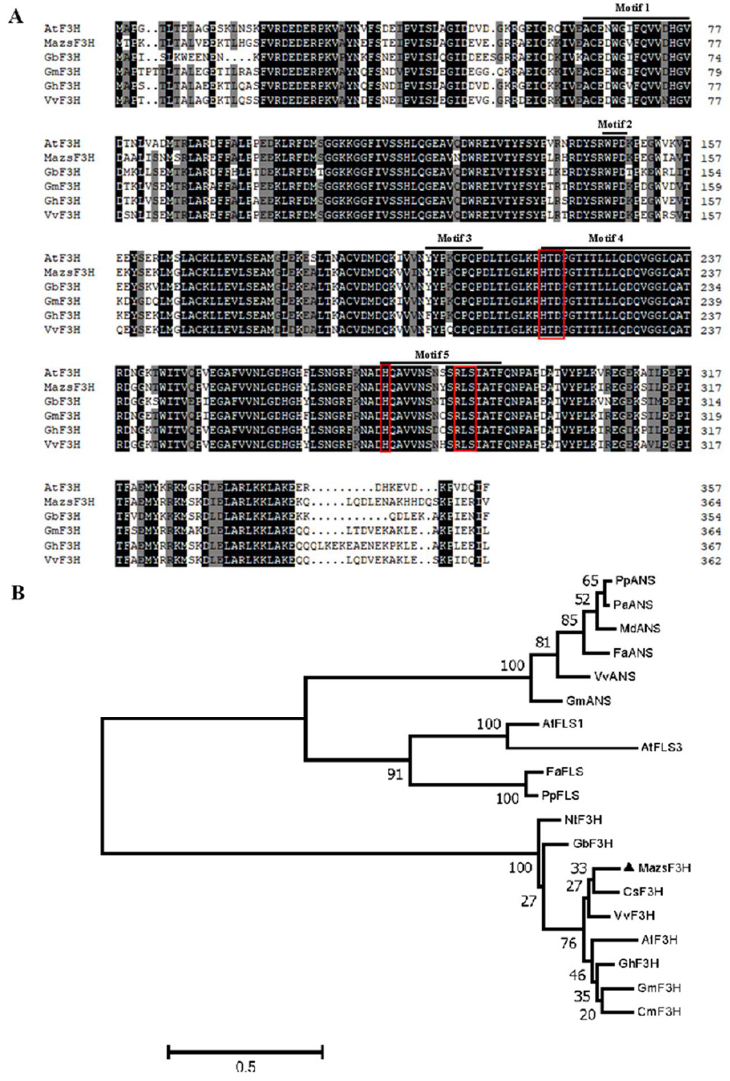
Figure 1. Alignment and phylogenetic analysis of F3Hs: ( A ) alignment of mulberry MazsF3H and other F3Hs from different plants. Red boxes indicate the ferrous iron ligation motif HXDX55H and